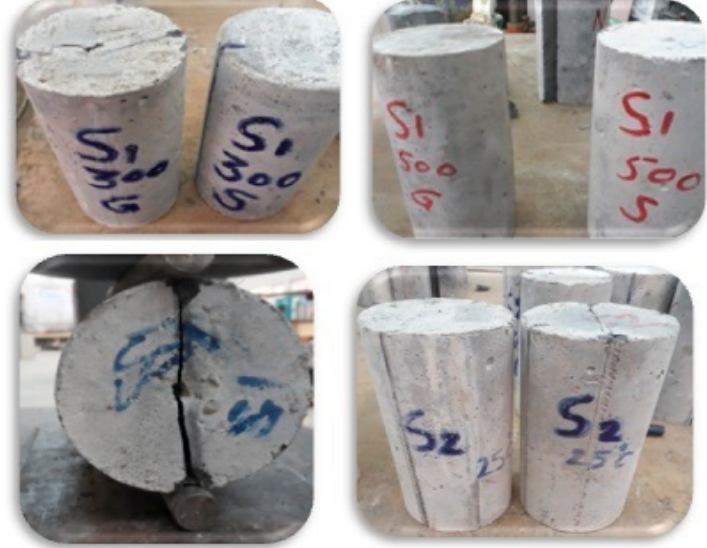
Figure 7. RPC samples at di ff erent burning temperatures and steel fiber volume fraction percentage after splitting tensile strength test.